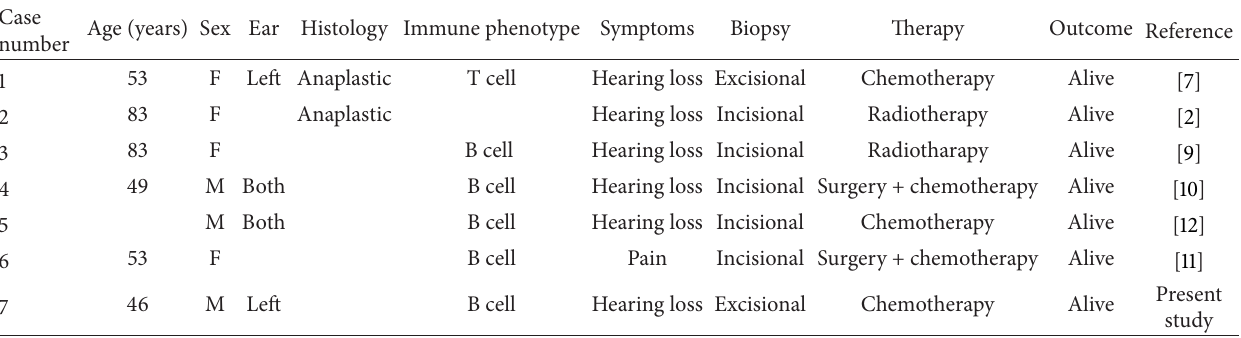
Table 1: Age, sex, phenotype, symptoms, and management of seven patients and nine lymphomas. All the cases are described in the scientific